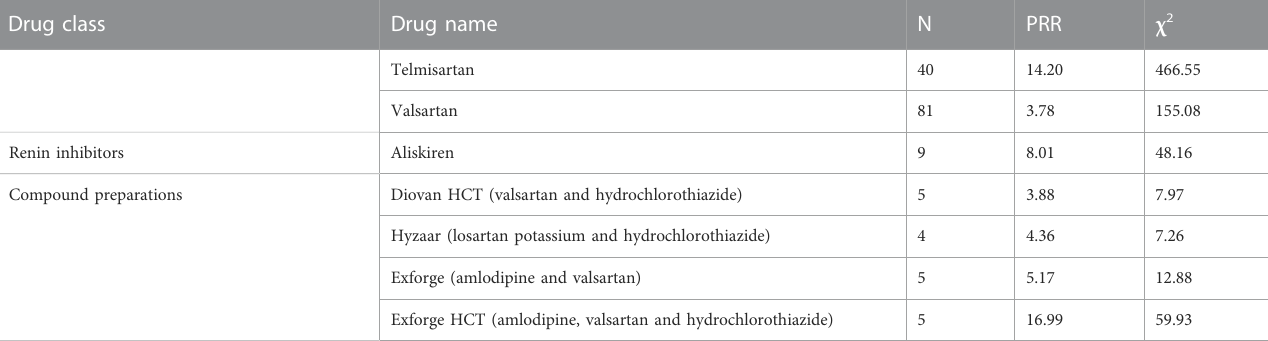
TABLE 2 ( Continued ) Antihypertensive drugs with positive signals for hyperuricaemia.